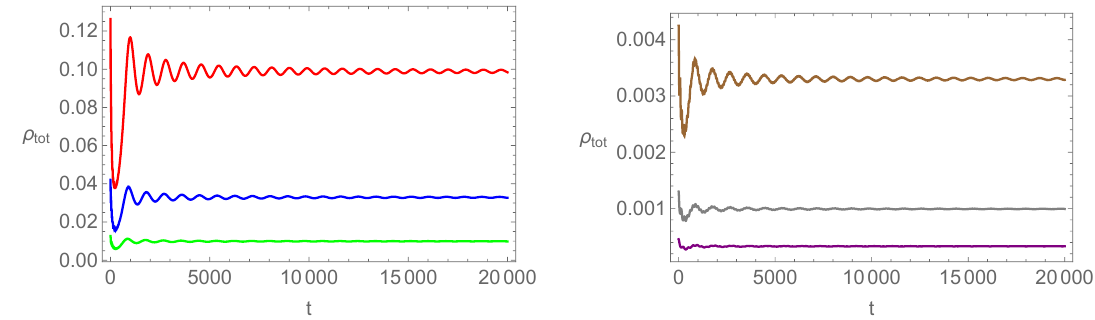
Figure 9. Time evolution of ρ tot defined in (3.29). The parameter is chosen from the bottom to the top as σ = 3 . 7 , 4.8, 6.0, which correspond to m 2 b 2 = 0 . 001 , 0.003, 0.01 in the left plot, and ∗ vac = 0 . 03 , 0.1, 0.3 in the right plot, respectively. The σ ∗ = 7 . 1 , 8.3, 9.4, which correspond to m 2 b 2 vac other parameters are chosen as